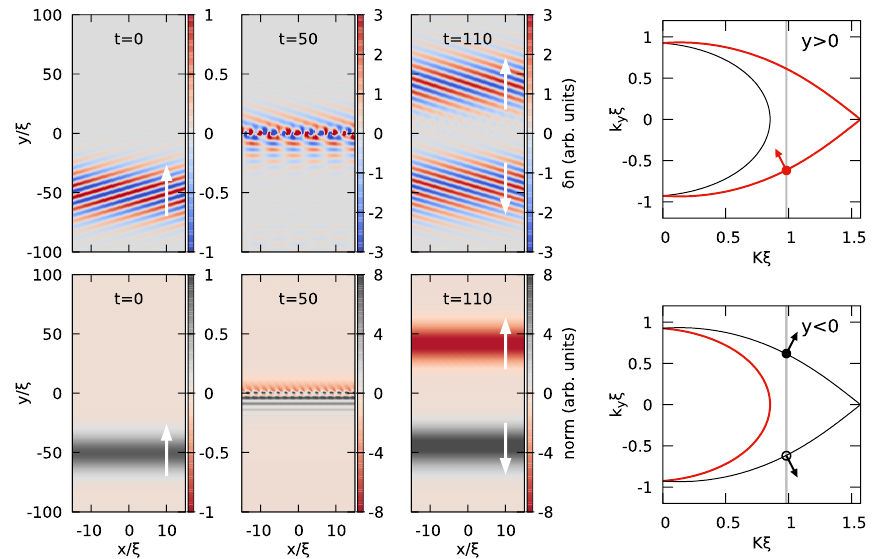
Figure 8: Left panels: snapshots of the time evolution of the Bogoliubov equations starting from an initial wavepacket at ω = 0 with a wavevector chosen to travel to- wards the array of vortices. In the top row we plot the density variation δ n with respect to the stationary state Ψ ∆ , in the bottom one we plot the pointwise Bo- v goliubov norm | U ( x , y ) | 2 − | V ( x , y ) | 2 of the excitations. White arrows indicate the direction of motion of the wavepackets. Right panels: dispersion relation in the first Brillouin zone at fixed ω = 0 in the uniform regions far enough above and below the array of vortices. Black thinner lines are positive-norm modes, red thicker lines negative-norm ones. The gray vertical line indicates the conserved Bloch wavenum- ber at which we are working, and the dots indicate the modes involved in the scat- tering process, with the arrows pointing in the direction of their group velocity. The considered case corresponds to ∆ v = 3.14 c and gives rise to the kind of superradi- s ant scattering of phononic waves that is at the basis of the